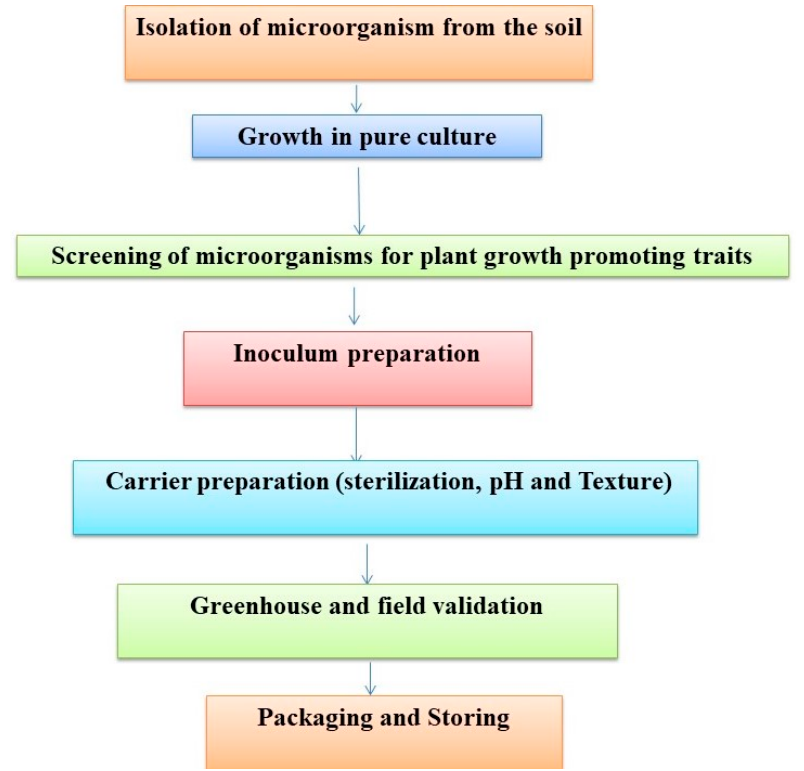
Figure 3. Simplified flow chart for the production of